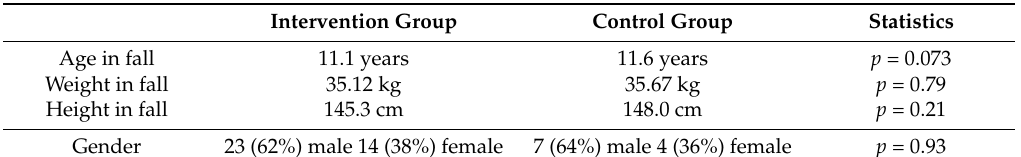
Table 2. Participant anthropometric